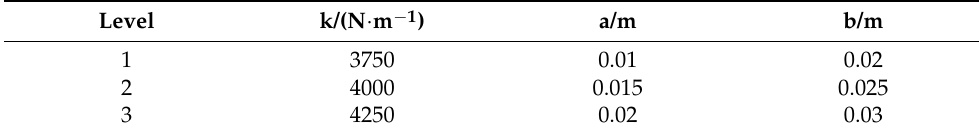
Table 1. Selection of test parameters.